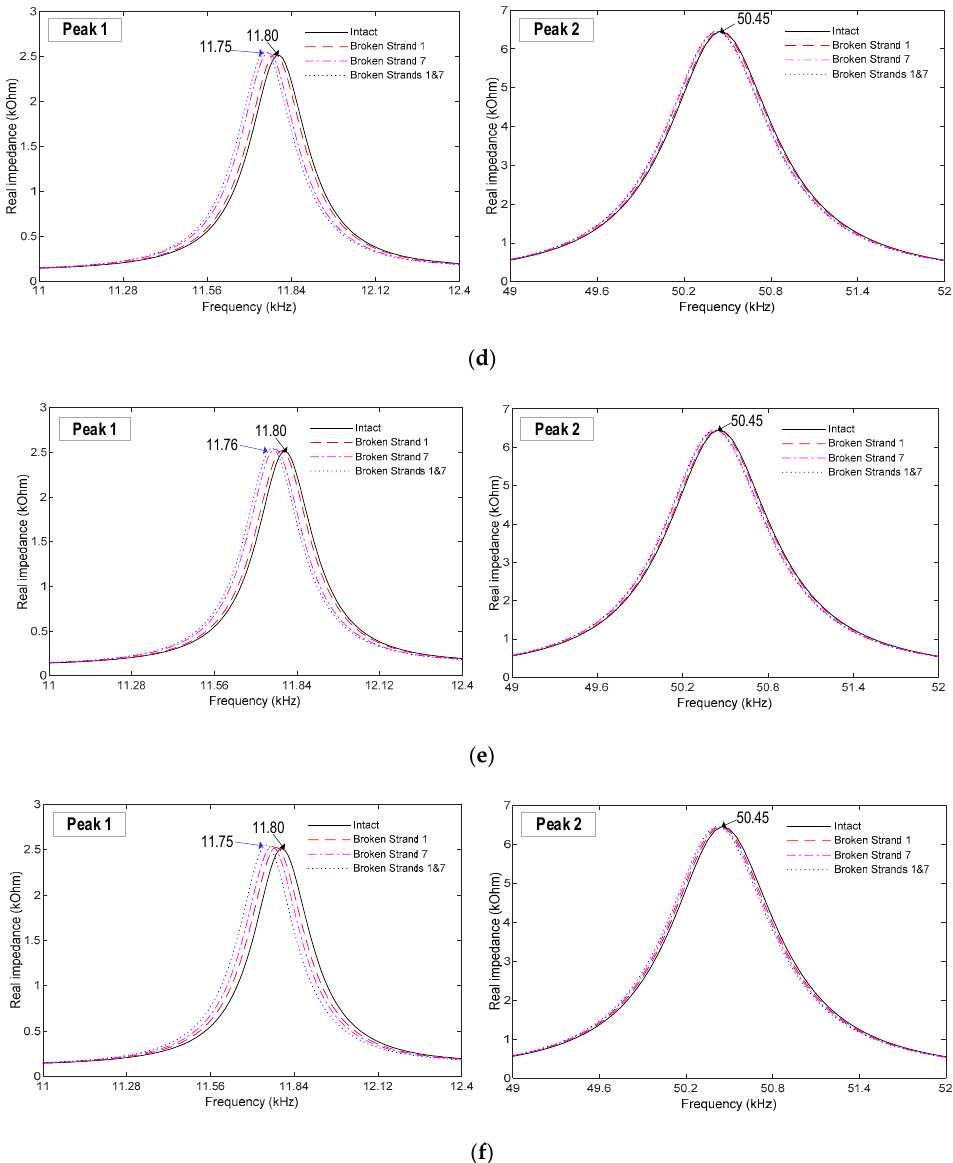
Figure 12. Impedance responses under strand breakage events. ( a ) PZT 1, ( b ) PZT 2, ( c ) PZT 3, ( d ) PZT 4, ( e ) PZT 5, and ( f ) PZT 6.